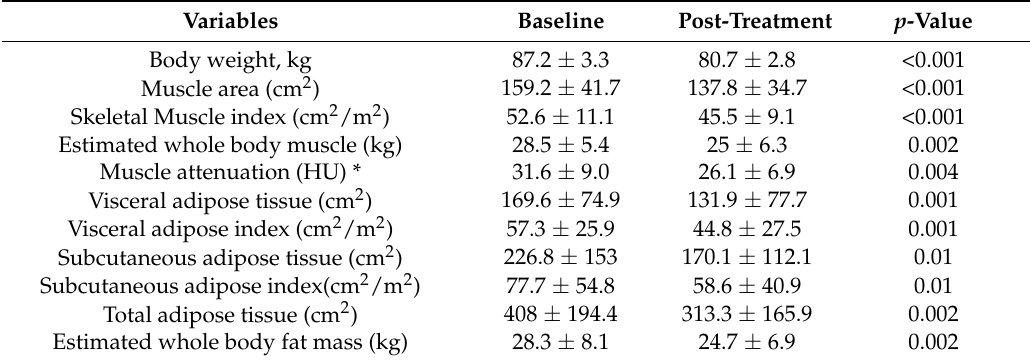
Table 3. Anthropometric variables of patients at baseline and post-treatment.